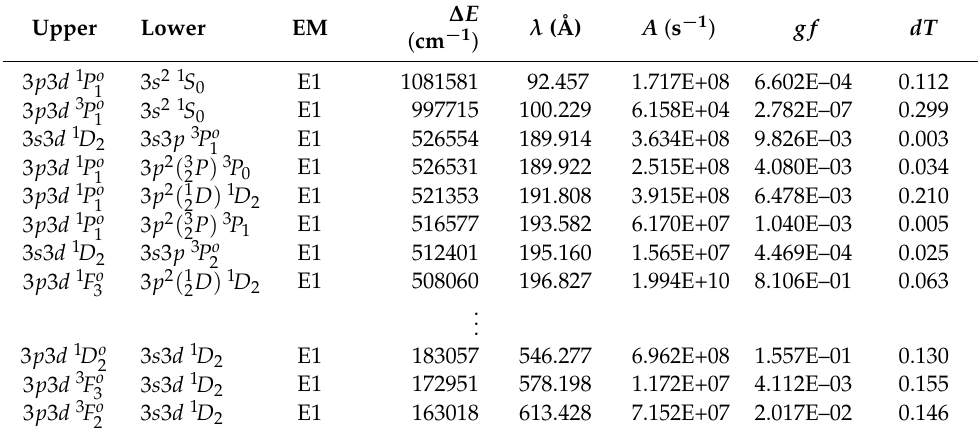
Table 4. Transition data.